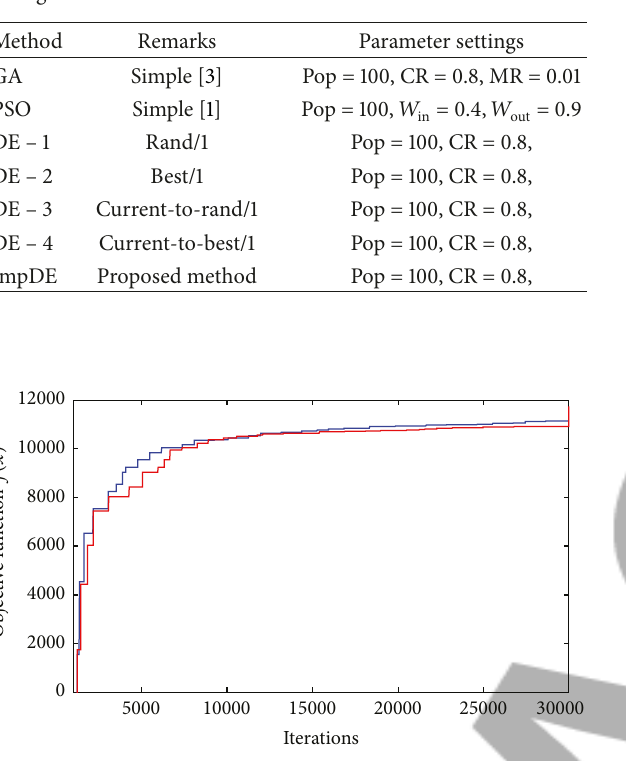
Table 1: Various methods for experiment and their Parameter settings.